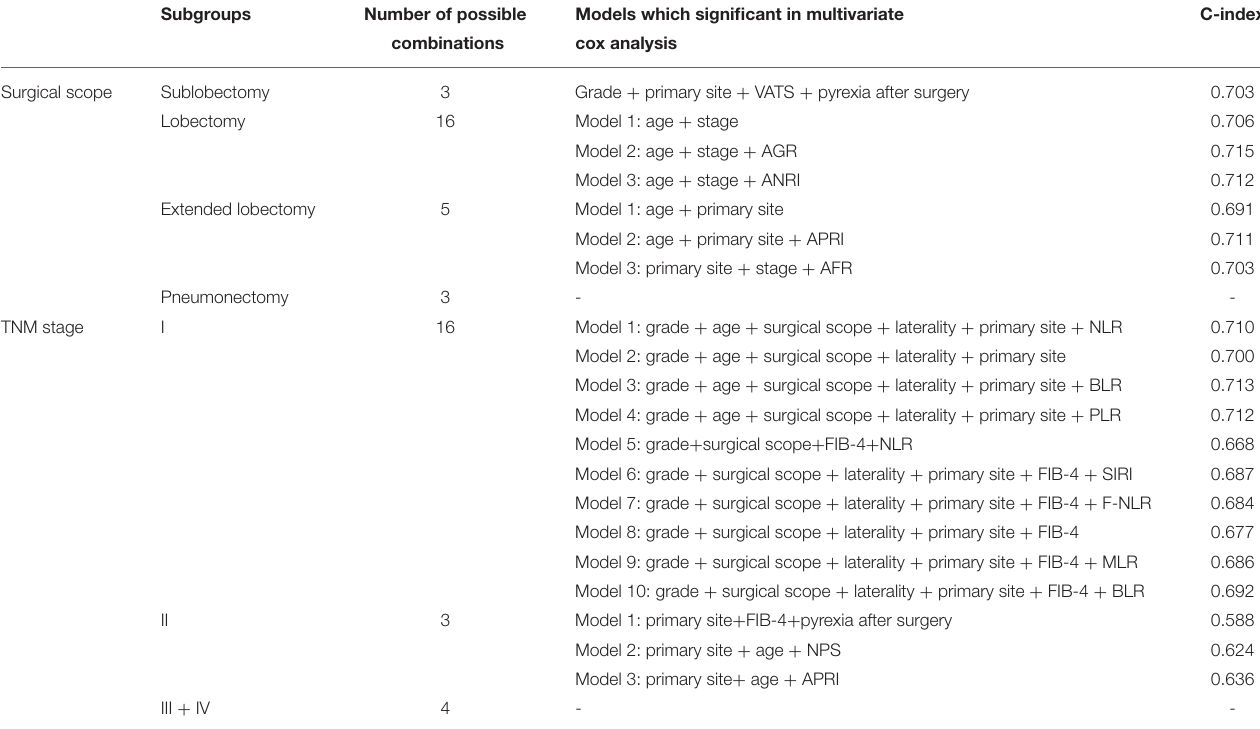
TABLE 3 | Subgroup analyses of prognostic models for surgical scope and TNM